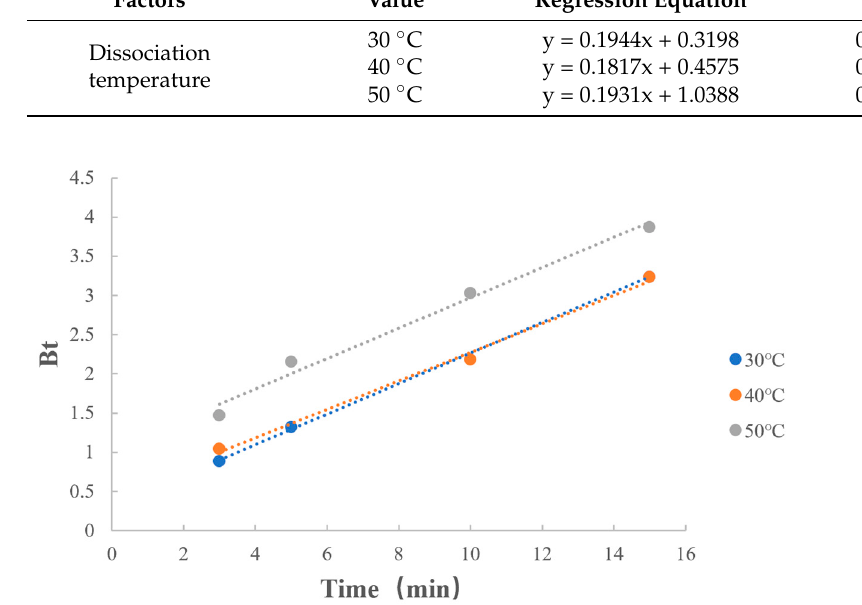
Figure 12. Boyd model fitting on dissociation temperature.